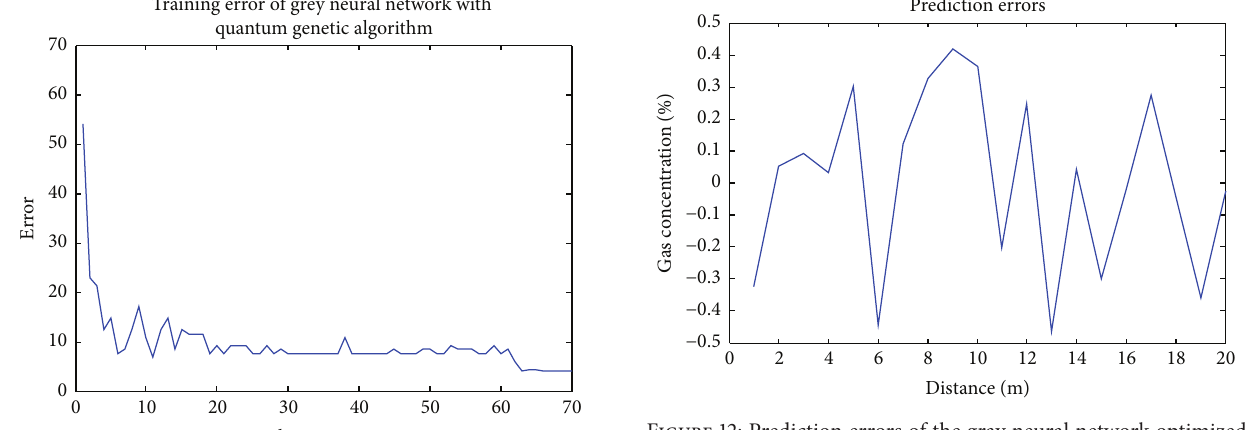
Figure 12: Prediction errors of the gray neural network optimized by the quantum genetic